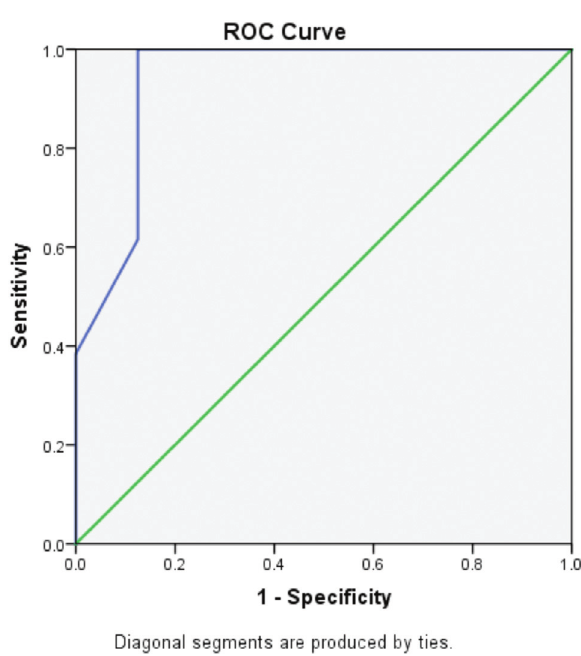
Bar graph represents the percent for each difficult food texture that causes dysphagia.